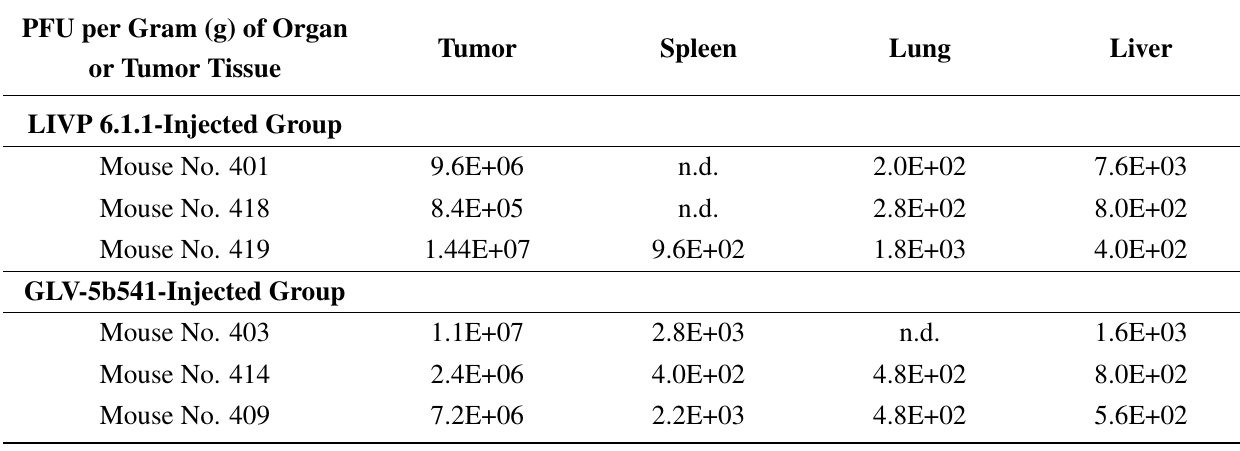
Table 1. Biodistribution of either LIVP 6.1.1- or GLV-5b451-injected STSA-1 xenografts